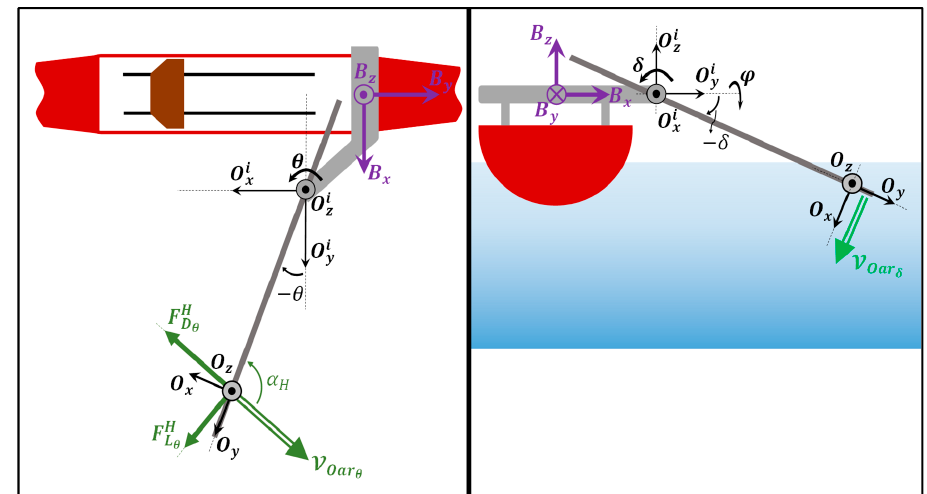
Figure 2. Coordinate systems and forces acting on the blade in the BIFC (binary blade immersion, fixed drag/lift coefficients) model. Forces due to horizontal oar movement are shown in the left pane (top view). the vertical force on the blade is shown in the right pane (back view of the boat). Calculated rowing forces at the portside (right) oar blade were mirrored onto the bow side (left) blade, simulating identical rowers for a pair boat. As a result, the rotation of the simulated boat around the 𝐵 (cid:3053) -axis was assumed to be 0 ° , and the linear displacement of the boat was constrained to be along the 𝐵 (cid:3052) -axis for simplicity.